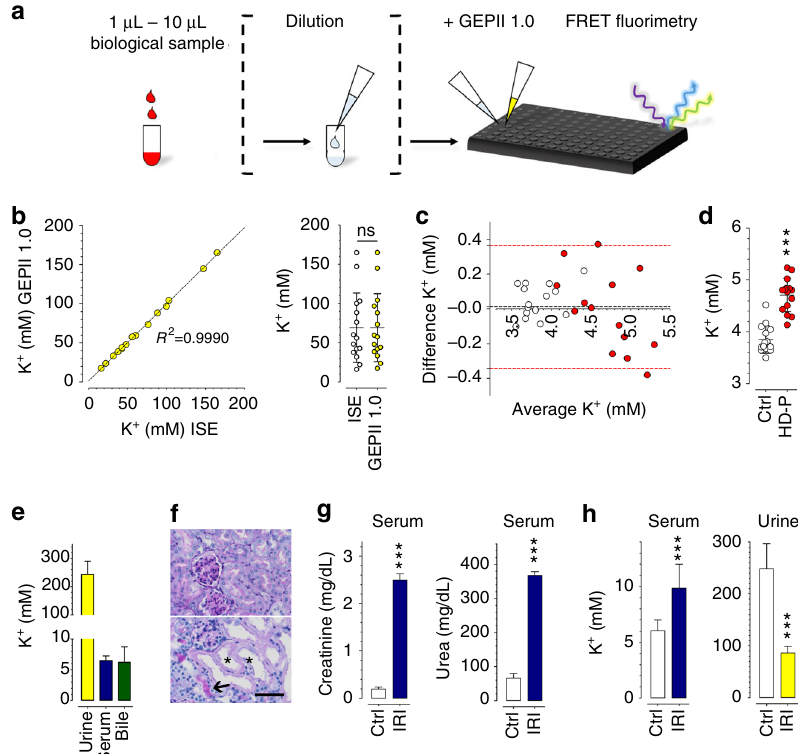
Fig. 2 Application of puri fi ed GEPII 1.0 to determine K + levels within biological samples. a Schematic work fl ow of an automatable K + determination assay. b Urine [K + ] of healthy human donors was determined using GEPII 1.0 in vitro and plotted against [K + ] in the same samples determined with ion-selective electrodes (ISE, n = 15, P = 0.9625, paired t -test). c Bland – Altman plot showing human plasma [K + ] of healthy donors (white circles, n = 15) and hemodialysis patients (red circles, n = 15) determined using ISE and puri fi ed GEPII 1.0, respectively. Bias (black dashed line) and 95% limits of agreement (red dashed lines) are shown ( n = 15, P = 0.6504, paired t -test). d Comparison of individual K + levels of human plasma samples determined using recombinant GEPII 1.0 of healthy controls (ctrl, n = 15 ± SD) and hemodialysis patients (HD-P, n = 15 ± SD, *** P < 0.0001, unpaired t -test). e [K + ] of mouse urine ( n = 11, ± SD), serum ( n = 25, ± SD), and bile ( n = 7, ± SD) samples quanti fi ed with recombinant GEPII 1.0. f Representative images of periodic acid- Schiff stained kidney slices of a control mouse (upper panel) and a mouse after ischemia-reperfusion injury (IRI). Scale bar represents 50 µ m. Black arrow indicates a tubular cast; black stars mark dilated tubules with loss of brush borders. g Serum creatinine and serum urea levels of control mice (white bars) and mice after IRI (blue bars, n = 5 for each, ± SD, *** P < 0.0001, unpaired t -test). h Serum (left columns) and urine (right columns) [K + ] of control mice (white bars, n = 8 for both ± SD) and mice after IRI (blue bar and yellow bar, n = 18 for serum, n = 3 for urine ± SD, *** P < 0.001, unpaired t